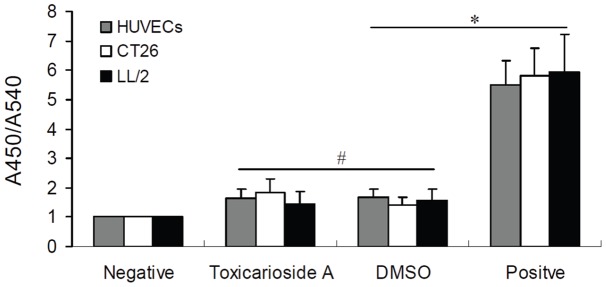
No affect on cell apoptosis in vitro.HUVECs, CT26, and LL/2 cells were treated with toxicarioside A or DMSO for 24 h. Thereafter, cells were fixed and nick-end labeled. The number of nick-ends (A450 nm) was divided by the number of cells as evaluated by crystal violet staining (A540 nm). A450/A540 nm signals were normalized to the signal obtained in unlabeled cells. These cells became the negative group. Cells in the positive group were treated with TACS nuclease after fixation and then nick-end labeled. Toxicarioside A treatment did not cause significant cell apoptosis. The graph shows the results of a representative experiment run in triplicate. Data are expressed as mean ± SEM. * P<0.001 and #
P>0.05.